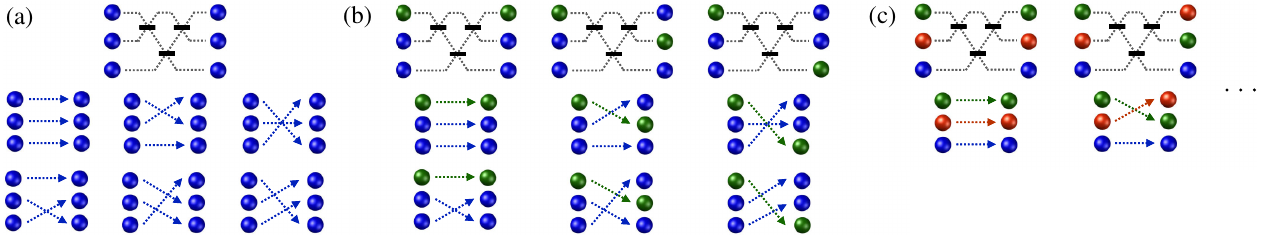
FIG. 1. Three-particle transition amplitudes of (a) indistinguishable (indicated by identical coloring), (b) partially (two different colors), and (c) fully (three different colors) distinguishable particles. In the fully indistinguishable case, six indistinguishable three- particle transition amplitudes add coherently to determine the output event ’ s probability [32]. In the partially distinguishable case, the six transition amplitudes from diagram (a) fall apart into three mutually distinct pairs of interfering two-particle amplitudes. In the fully distinguishable case, no — now perfectly distinguishable — transition amplitudes superimpose coherently